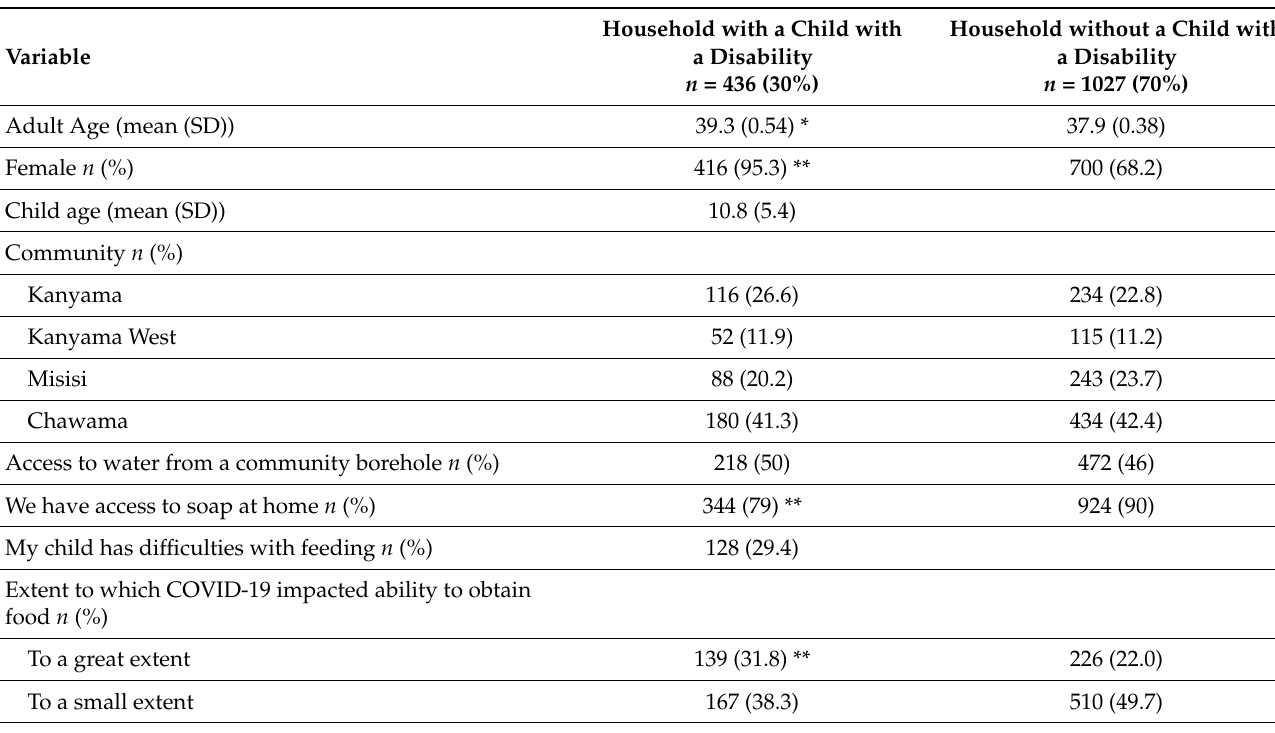
Table 1. Demographic descriptions of households with a child with disabilities and households without a child with a disability, Lusaka, Zambia